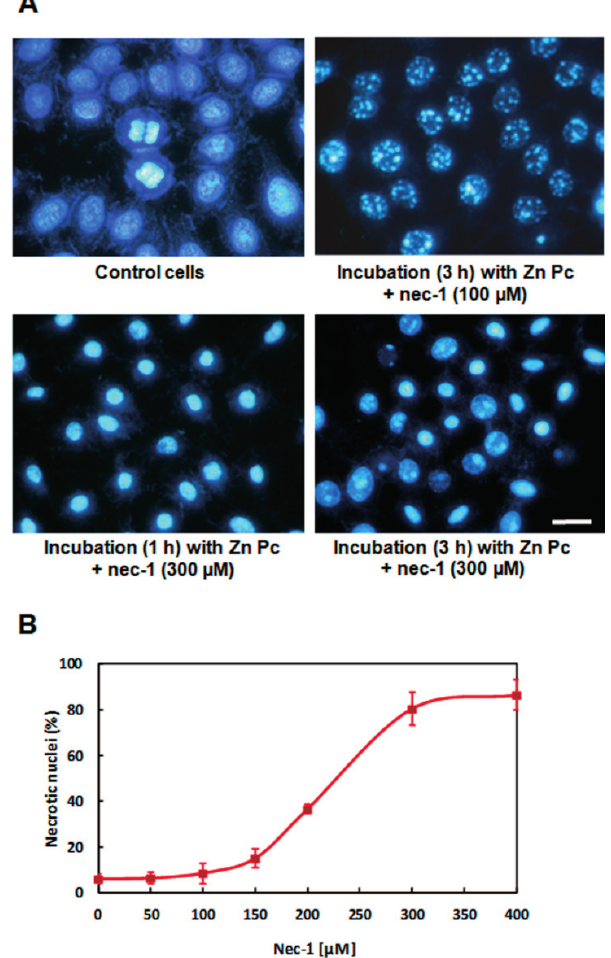
Figure 5. Effect of 300 µM nec-1 on the survival and nuclear morphology of HeLa cells incubated with 1 µM ZnPc (1 and 3 h) and evaluated 24 h after photodynamic treatment. ( A ) Cells stained with H-33258 and observed in fluorescence microscopy under UV excitation light; ( B ) the percentage of necrotic nuclei in HeLa cells incubated with 1 µM ZnPc for 3 h in the presence of different concentrations of nec-1, irradiated and then stained with H-33258 24 h after treatment. The morphological counting was carried out in fluorescence microscopy under UV exciting light. Each value is the average of six independent experiments. At least 2000 cells were counted in each experimental